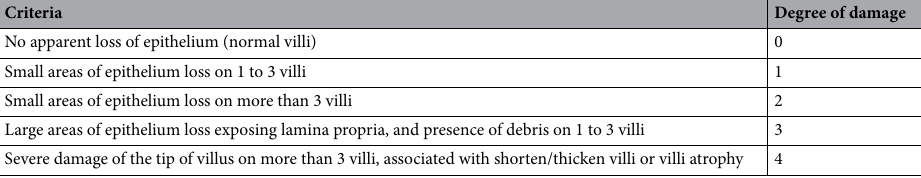
Table 3. Criteria for the assessment of ileal villus damage from SEM micrographs, modified from Gomide Junior et al. 94